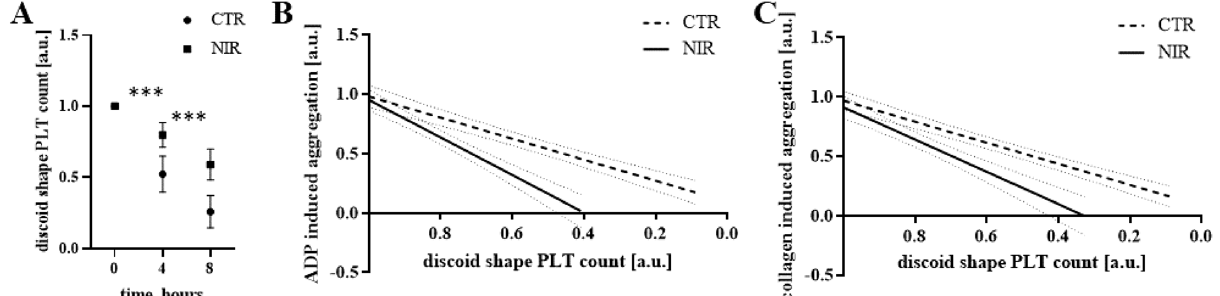
Figure 6. PLT function tests related to discoid shape PLT count changes during the experimental procedure. ( A ) A significant decrease in the number of discoid shape PLT in both groups (p < 0.001), while in NIR_1.5 PBM samples (filled square) the observed loss is characterized by a lower value throughout the experiment than for the CTR samples (filled circle). Collagen ( B ) and ADP ( C ) induced aggregation versus PLT for CTR (bold dashed line) and NIR_1.5 (bold solid line) groups approximated by linear regression. The slope coefficients in the two groups were significantly different (p < 0.01 for collagen and p < 0.001 for ADP). The thin dashed line